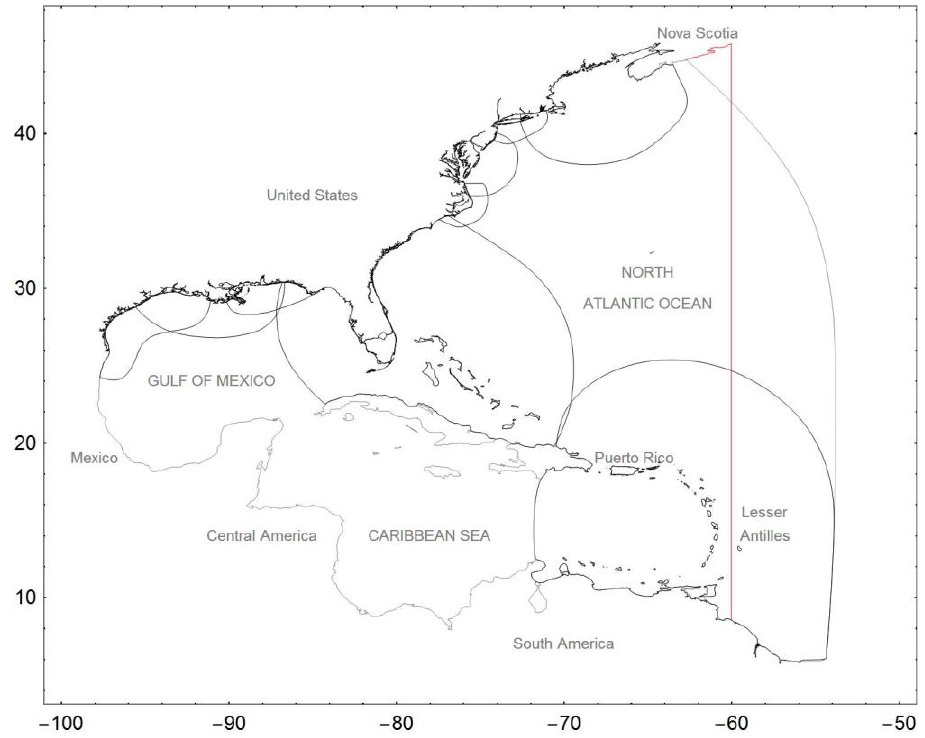
Figure 1. Location of new EC2001_extended model domain (shown in gray) compared to the traditional EC2001 boundary at the 60° W meridian (shown in red—remainder of shoreline is same as gray); and location of the nine VDatum domains (shown in black) used to update the coastal resolution and bathymetry in the EC2015 model. Note that the coarser gray shoreline is not visible underneath the black.